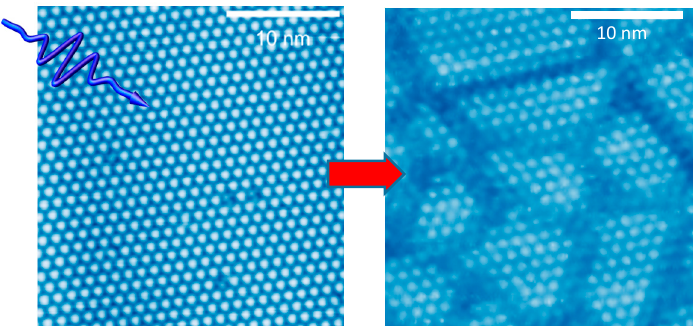
Figure 4. The formation of domains in the photoexcited hidden state (right) after excitation of the commensurate charge ordered state (left) in 1T-TaS 2 with 1mJ/cm2, 30 fs pulses at 800 nm [26].